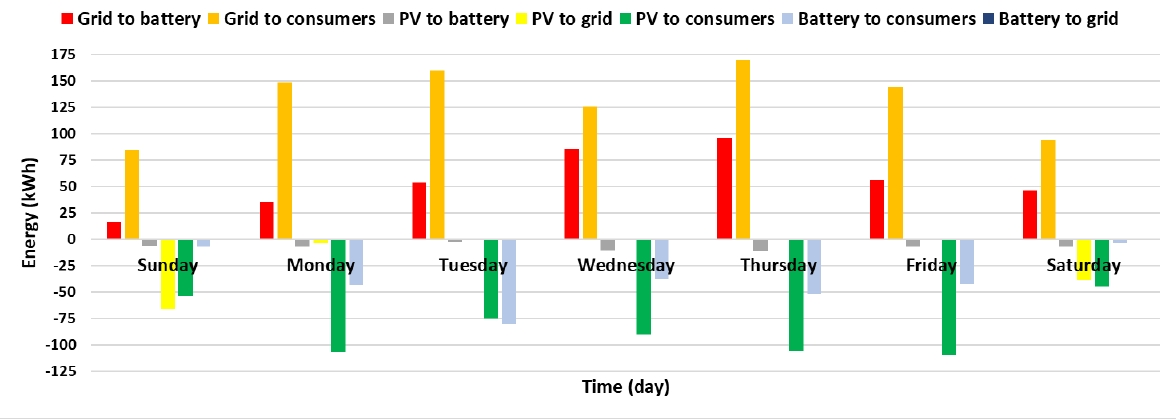
Figure 10. Total energy balance in the hybrid mini-grid.